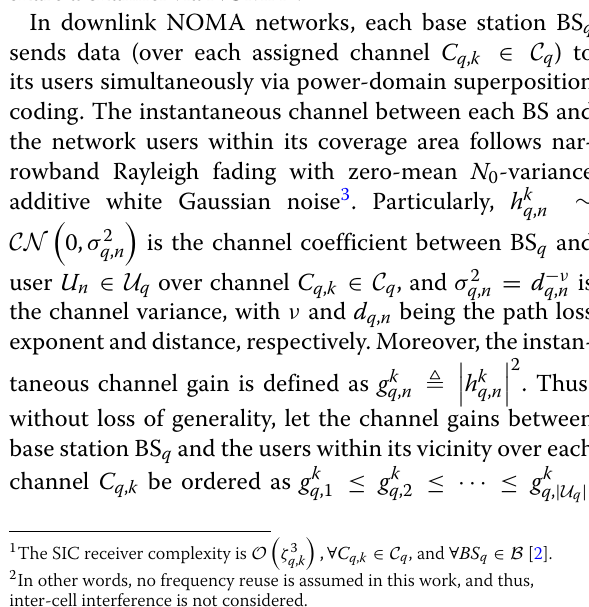
by at most ζ q , k users, ∀ BS q ∈ B 1 . Moreover, note that some network users may fall within the overlapping